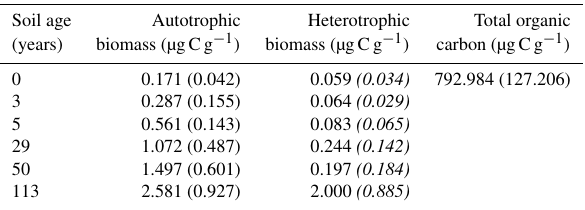
Table 2. Microbial biomass in the forefield of Midtre Lovénbreen (brackets show 1 standard